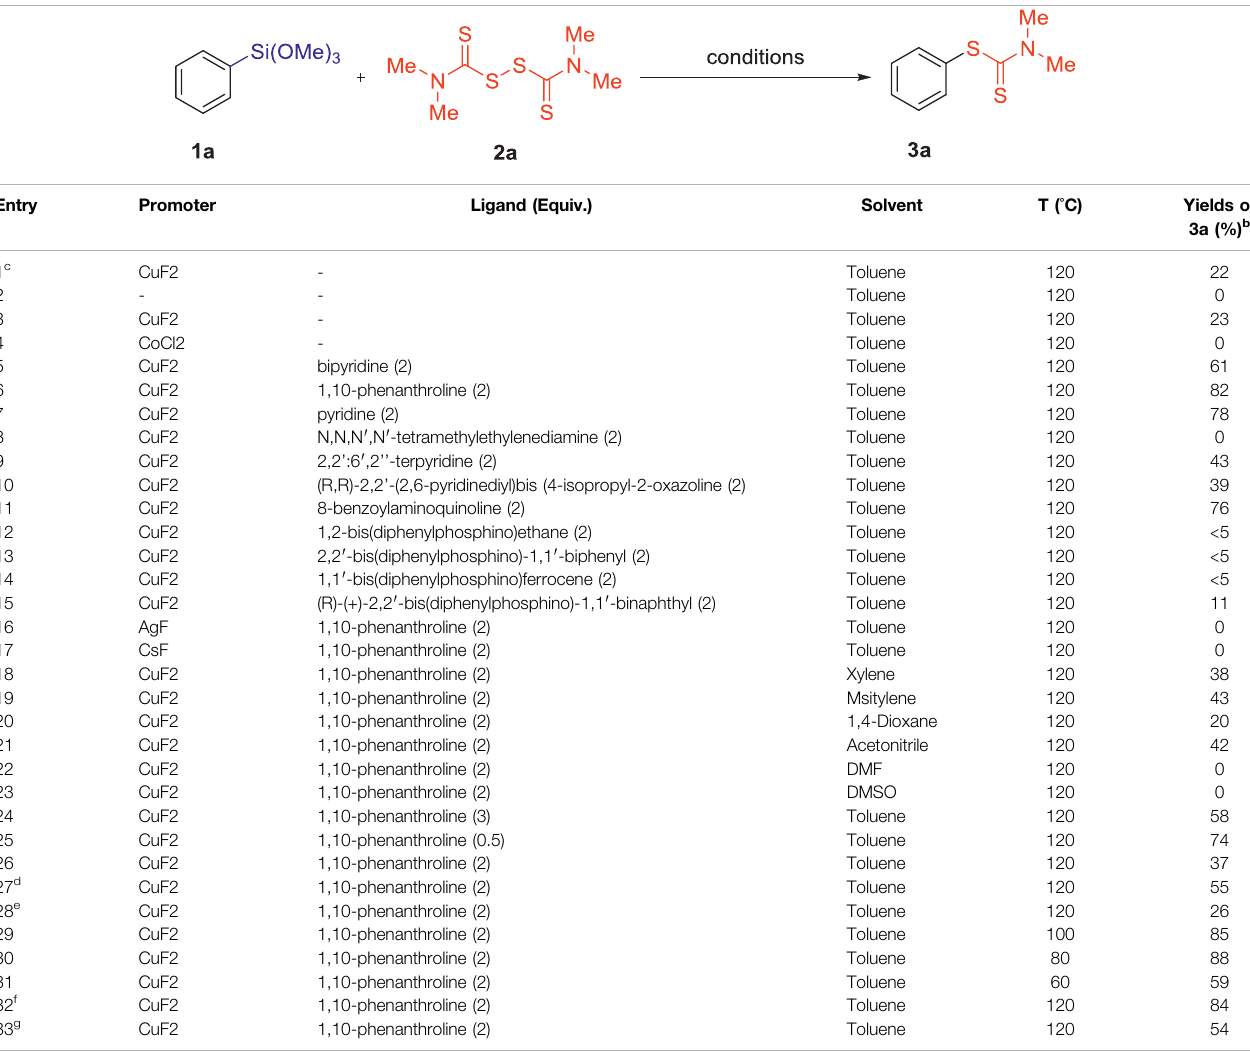
TABLE 1 | Optimization of reaction conditions a